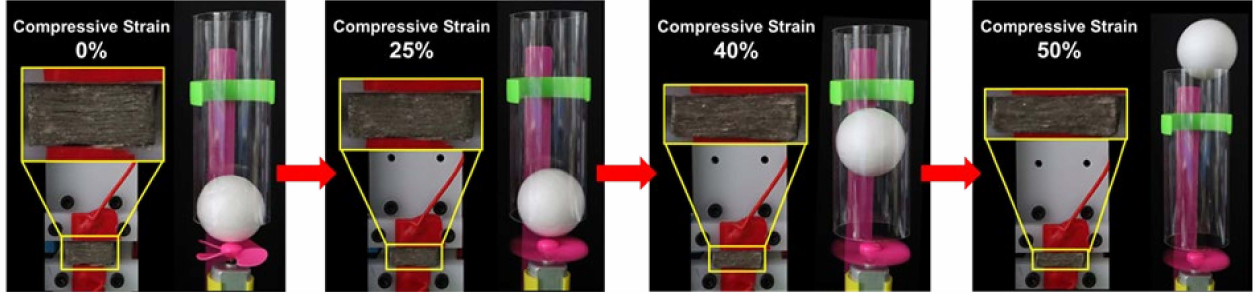
Figure 10. Digital images of electronic circuits. The as-made Ni-PW was used as electronic pressure sensor for blowing up a white ball by driving a pink